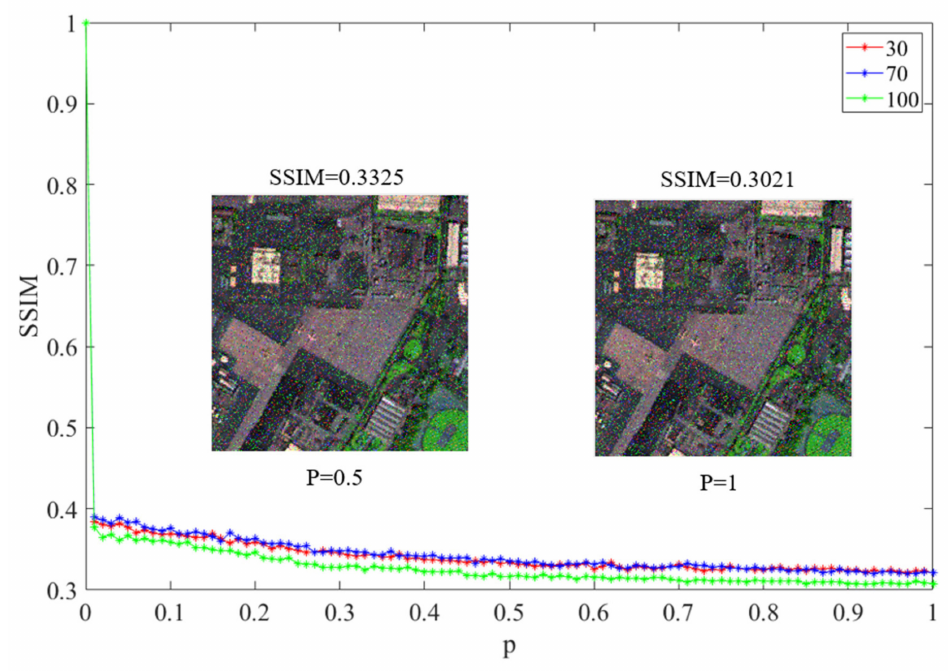
Figure 11. The SSIM curve of noise attack including decrypted image obtained with p = 0.5, and decrypted image obtained with p =